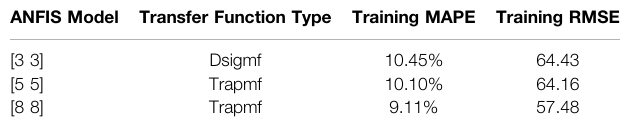
TABLE 5 | ANFIS model training